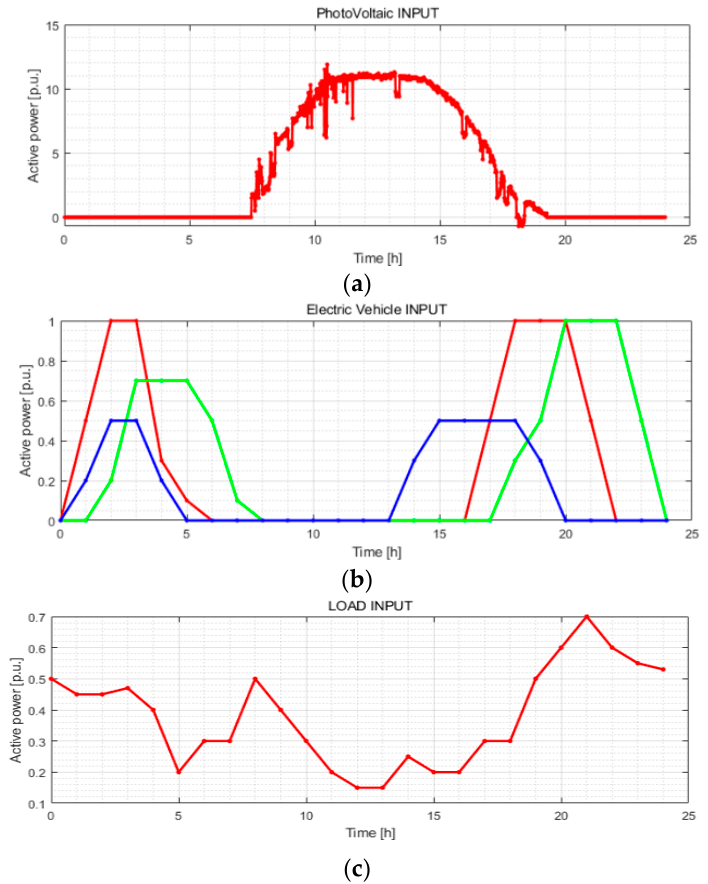
Figure 11. Output pattern of the EV charger, PV system and Load. ( a ) PV data (24 h). ( b ) EV charging data (24 h). ( c ) Load data using the PHILS (24 h). In addition, hosting capacity ( 𝐿𝐹 (cid:3035)(cid:3042)(cid:3046)(cid:3047)(cid:3036)(cid:3041)(cid:3034) ) of VPL is adopted to 70% (21 kW) of rated power (30 kW) considering load HILS and EV capacity. It is expressed in Table 4. Table 4. Hosting capacity ( LF hosting ) of VPL. Hosting Capacity Characteristic